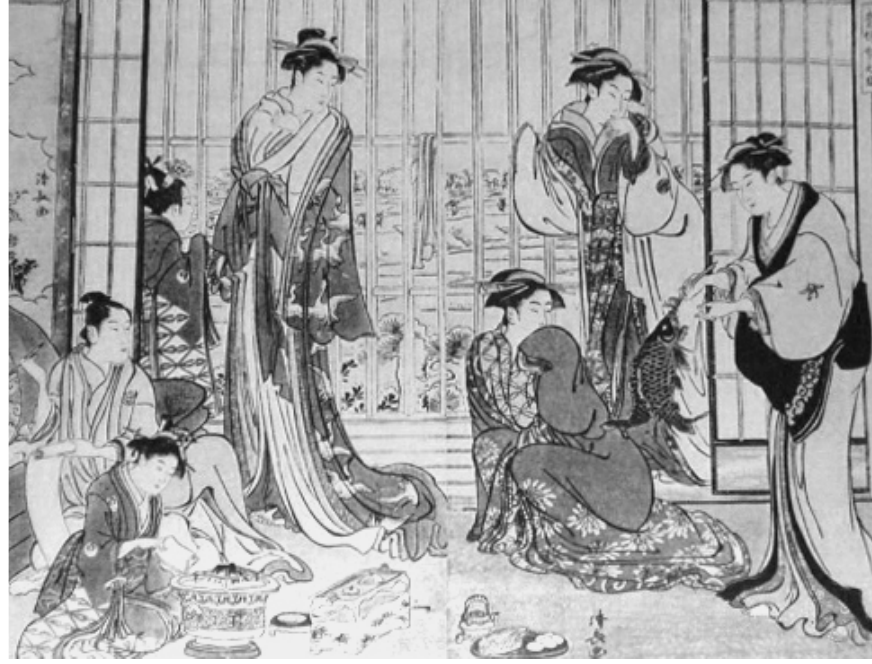
Figure 14 Morning Snow at the Brothel House , 1789. Torii